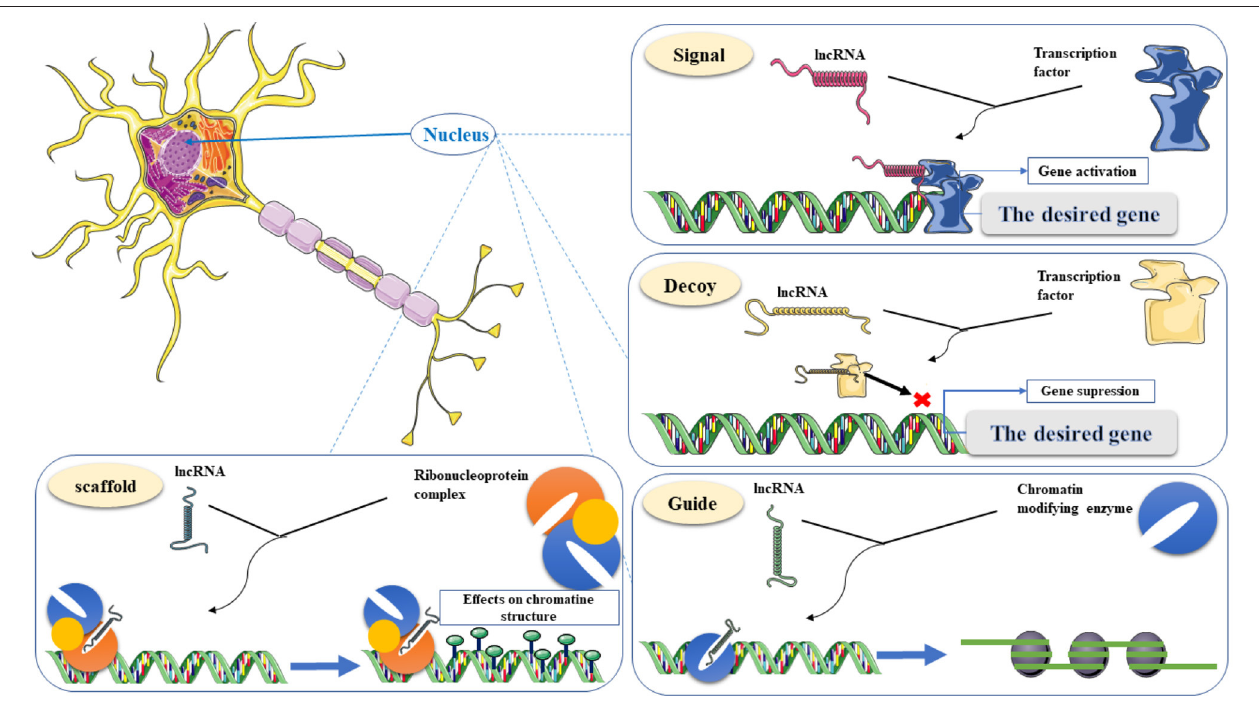
FIGURE 3 | Classification of lncRNA functions in gene transcriptional regulations, including Signal, Decoy, Guide, and Scaffold. Signal, recruiting transcriptional proteins to the target gene to enhance gene expression. Decoy, a “molecular sink” for RNA-binding proteins (RBPs). Guide, binding to chromatin-modifying enzymes and direct to the target for epigenetic modification. Scaffold, a nest for connecting several effective partners and transporting them simultaneously to one place. This graphical figure was created using the vector image bank of Servier Medical Art